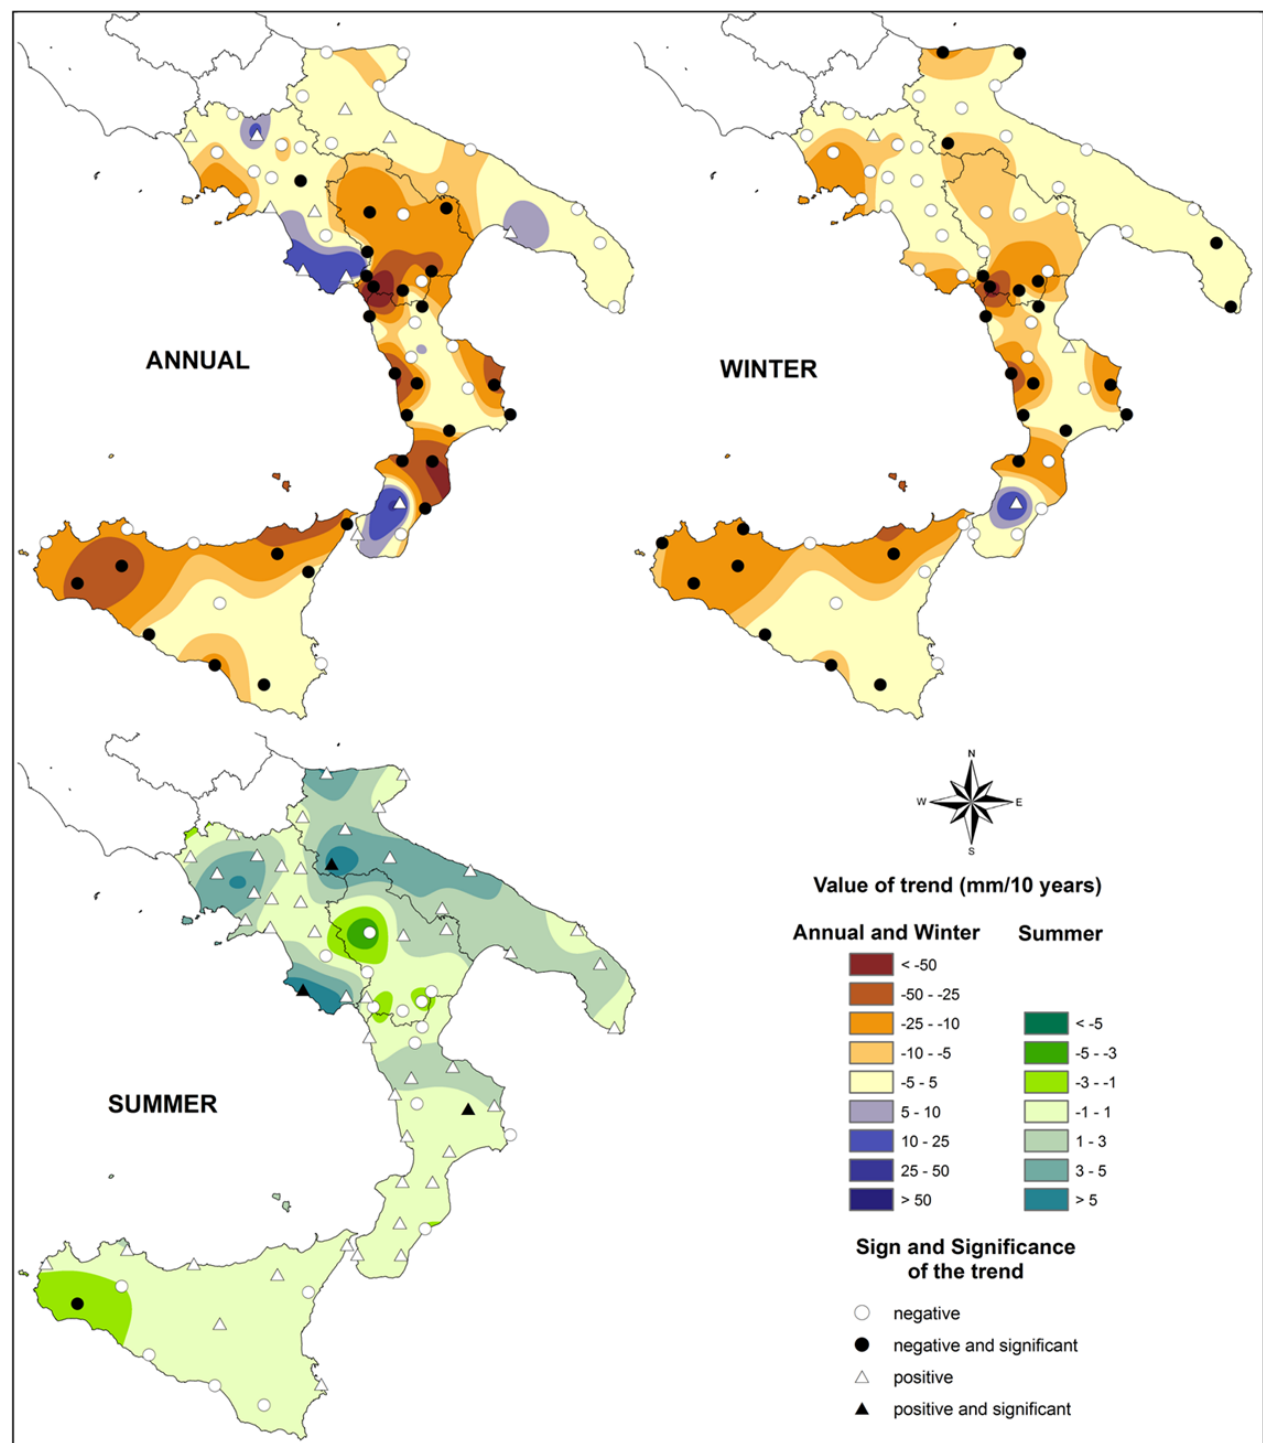
Fig. 5. Spatial distribution of trend values for the annual, winter and summer precipitation (mm/10years). For each rain gauge, the sign and the significance of the trend are evidenced through different